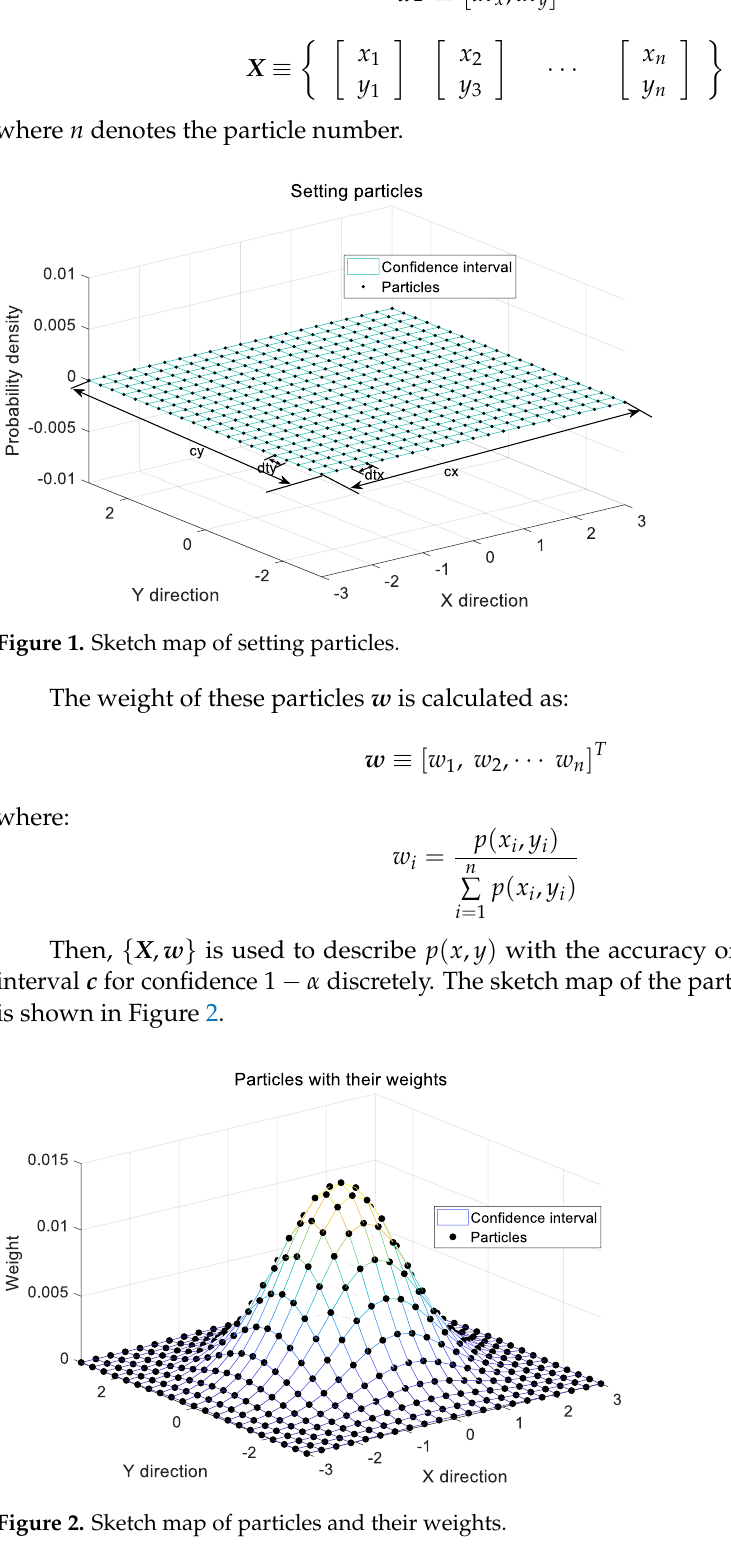
Figure 2. Sketch map of particles and their weights.